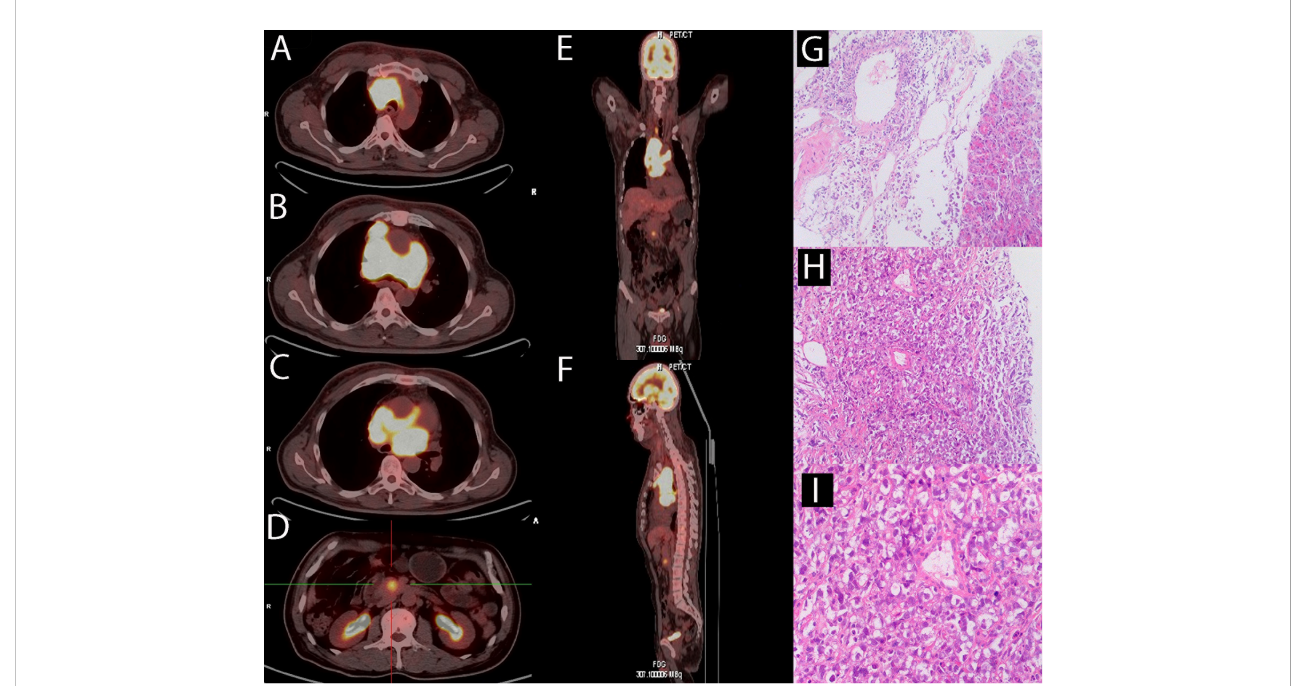
FIGURE 1 At diagnosis of lymphoma, a PET-CT scan and a biopsy were performed. (A-C) PET/CT revealed multiple enlarged lymph nodes in the middle and upper mediastinum and the maximum plane size was approximately 6.3 cm x 4.3 cm. There were masses showing in fi ltration around the ascending aorta and pulmonary artery. The SUVmax was 13.8. (D) PET/CT revealed the uncinate process of pancreas in fi ltration, with a diameter of about 2 cm and the SUVmax was 5.7. (E, F) Overall, there is no signi fi cant abnormal radiation uptake outside of the pancreas and mediastinal lymph nodes. (G) The hematoxylin-eosin staining revealed medium to large cells with irregular nucleus in the pancreas (original magni fi cation 10 x). (H, I) The hematoxylin- eosin staining revealed medium to large cells with irregular nucleus in the mediastinum (H:original magni fi cation 10 x; G:original magni fi cation 20